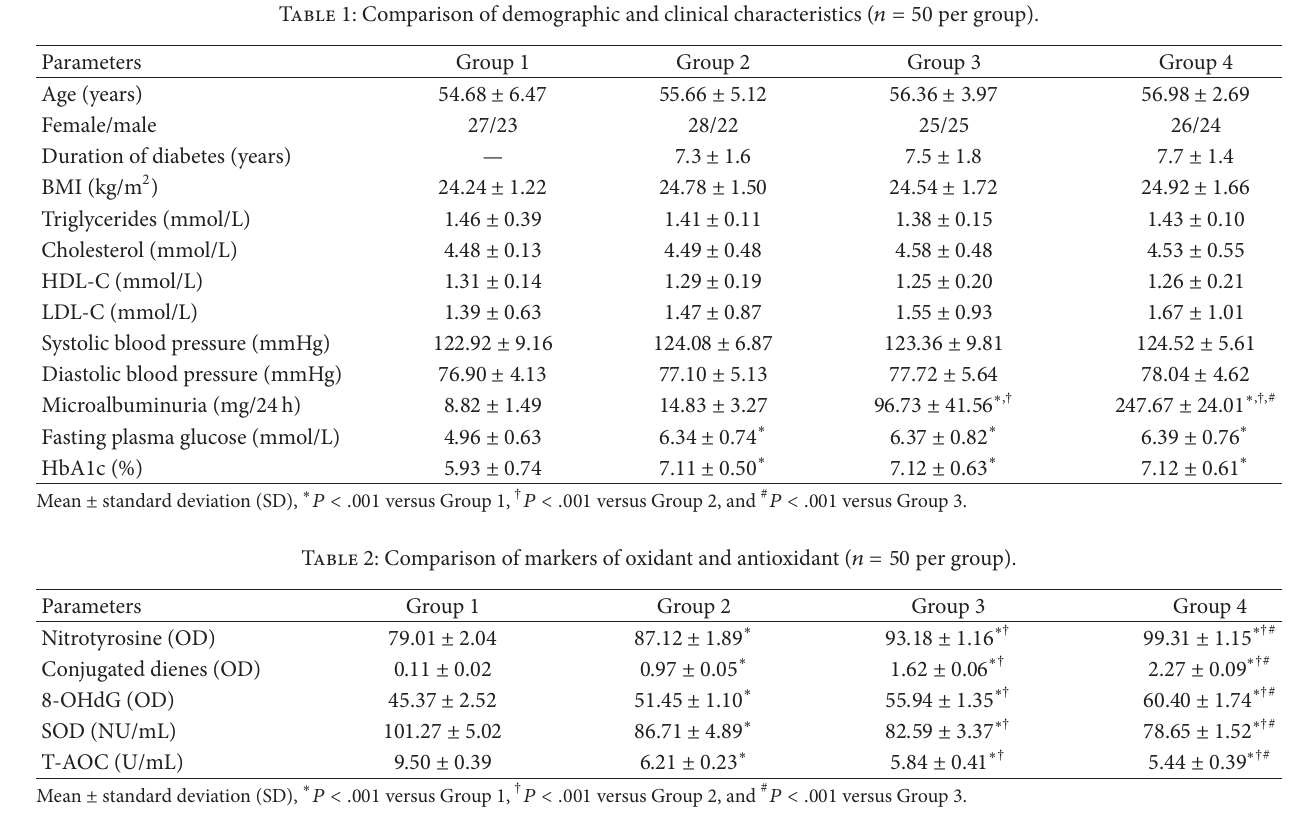
T 1: Comparison of demographic and clinical characteristics (